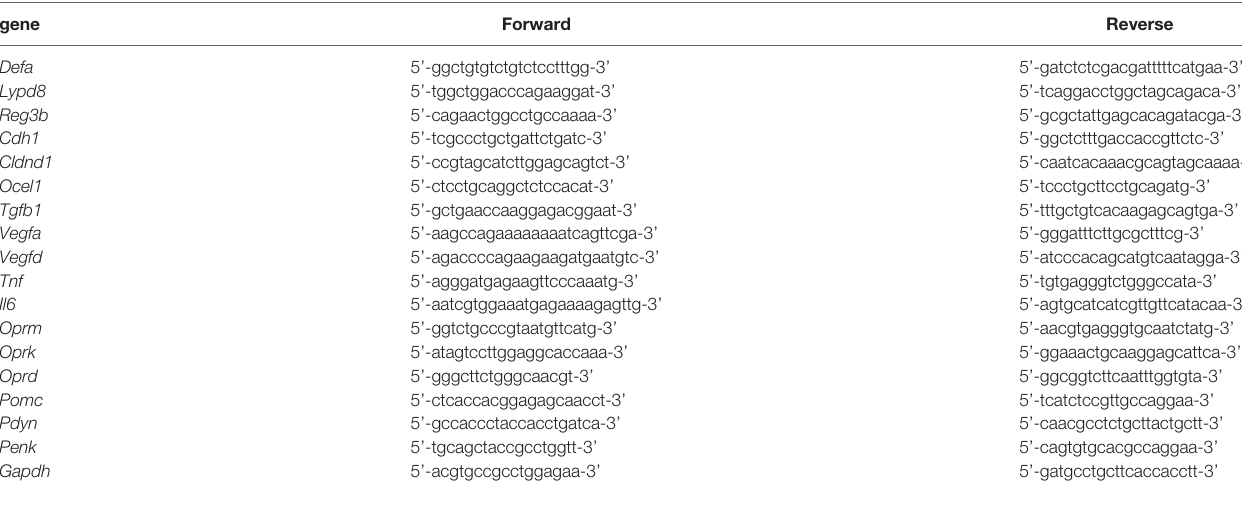
TABLE 2 | Nucleotide sequences of primers used in quantitative